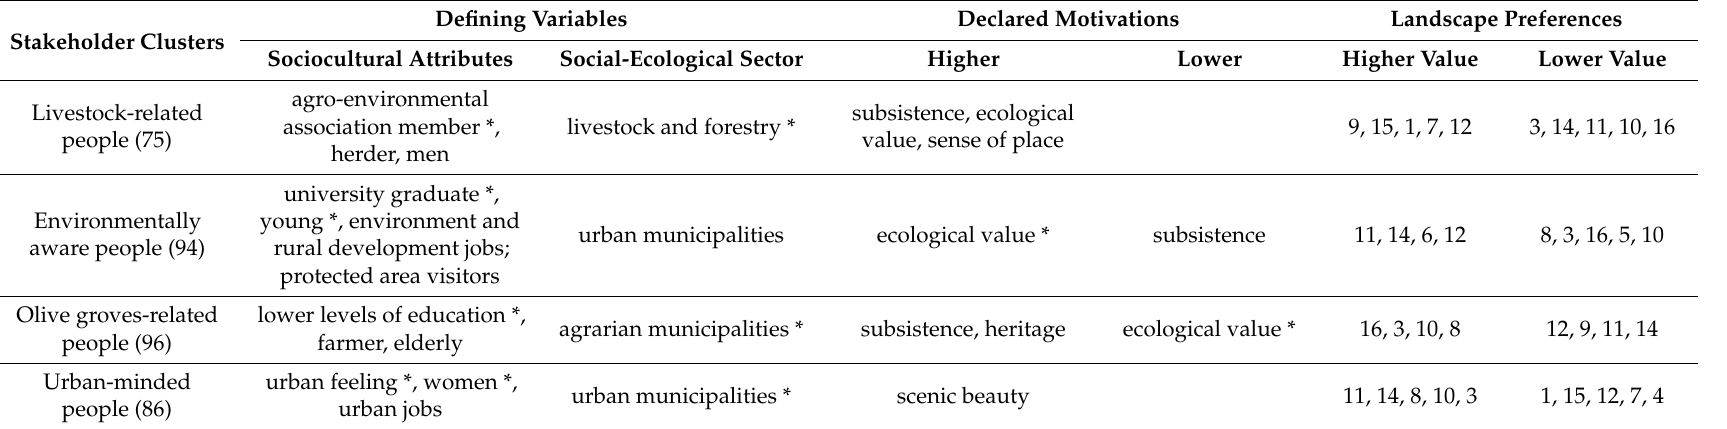
Table 2. Stakeholder